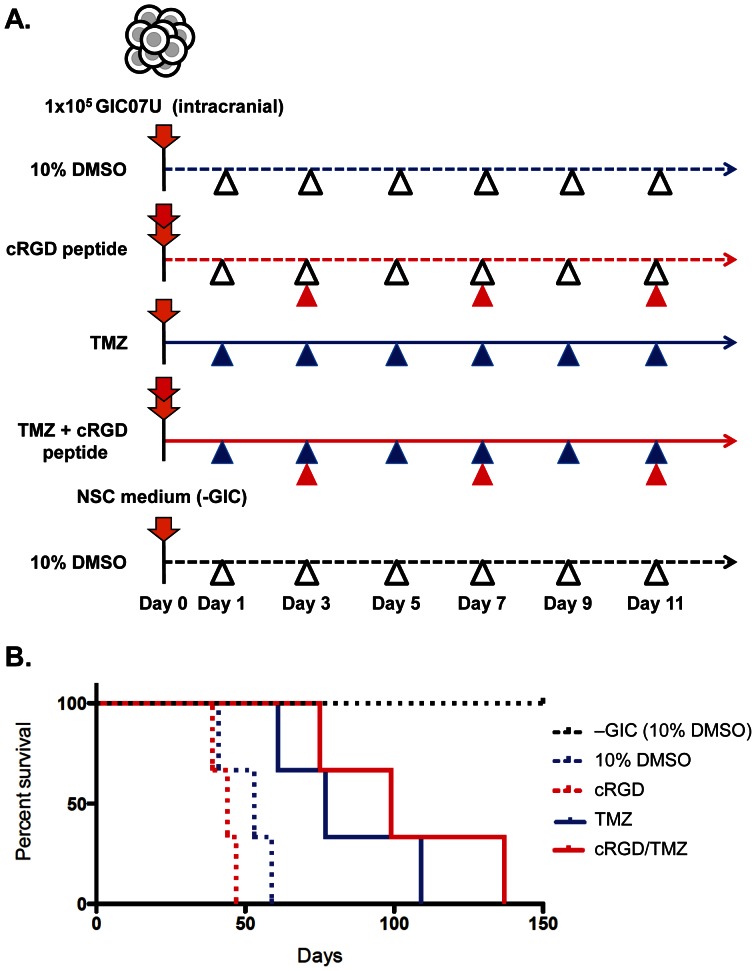
Combined treatment of cRGD peptide and TMZ prolonged mouse survival after GICs brain transplantation.
A. Therapeutic schedule for targeting GIC in the brain xenograft mouse model. Before transplantation of GIC, cells were pretreated with cRGD (100 µg/1×105 cells) (red down arrow) or/and control medium (orange down arrow) for 30 min at 37°C, and subjected to the intracranial injection. After the GIC injection, cRGD (5 mg/kg mouse, red arrowhead), TMZ (7.5 mg/kg mouse, blue arrowhead), both of cRGD and TMZ, or control 10% DMSO (5 ml/kg mouse, white arrowhead) was injected intraperitoneally (i.p.) each time point according to the experimental design. The schedule of the i.p. administration was shown, control DMSO (10%): blue dotted line; cRGD peptide: red dotted line; TMZ: blue solid line; cRGD and TMZ: red solid line, for xenograft models, and 10% DMSO: black dotted line for control mice. B. Kaplan-Meier survival curve of mice after GIC transplantation. The mice survivals after treatments of control 10% DMSO (blue dotted line, n = 3; median survival = 53 days), cRGD (red dotted line, n = 3; median survival = 44 days). TMZ (blue line, n = 3; median survival = 77 days), cRGD and TMZ combination (red line, n = 3; median survival = 100 days) were shown. All of control mice after NSC medium injection to brain without GIC (black dotted line, n = 3) were alive more than 5 months. p-value was determined with long-rank test (**p<0.0031).